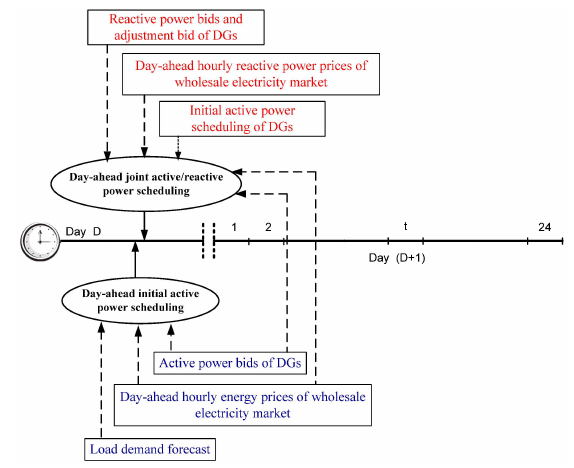
Figure 5. Time horizon of proposed joint active/reactive power dispatch model.